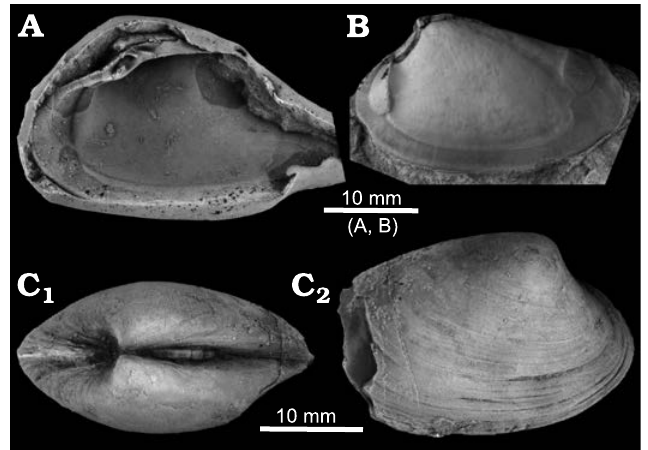
Fig. 4. The vesicomyid bivalve Squiresica marincovichi (Kiel and Amano, 2010), from the Oligocene Kulthieth Formation, Alaska, USA. A . Rubber peel of holotype UCMP 555221 showing internal features including hinge dentition of the right valve. B . Paratype UCMP 555223, internal mold of a left valve, showing adductor muscle scars and small pallial sinus. C . Paratype UCMP 555224, an articulated specimen showing inflation, lunular incision, and escutcheon (C 1 ) and external sculpture of right valve (C 2 ). All images from Kiel and Amano